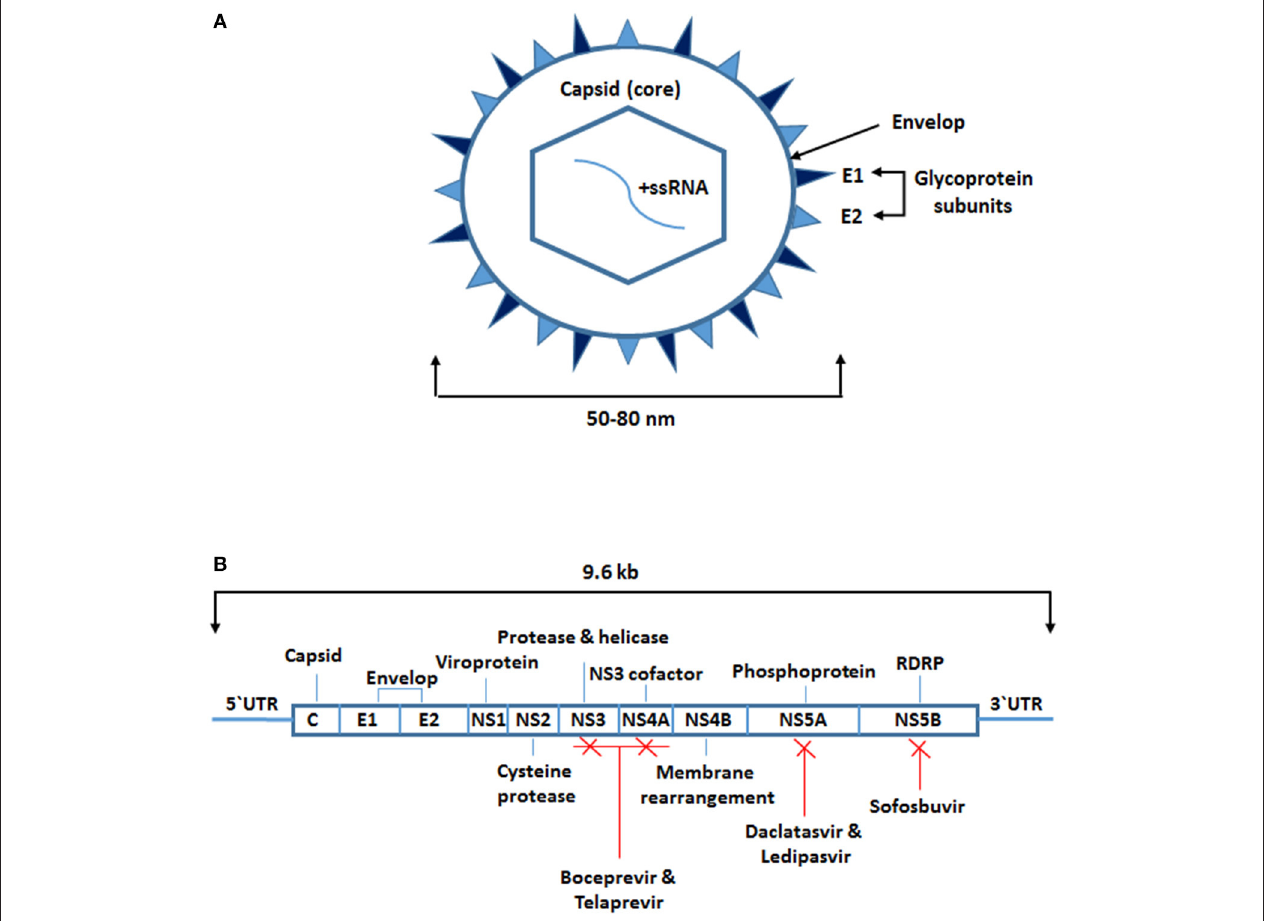
FIGURE 1 | Structure of hepatitis C virus and sites targeted by antiviral therapy. (A) A small spherical enveloped virus with molecular size between 50 and 80nm in diameter. The genome is a positive-sense single-stranded RNA molecule. The structural proteins include the capsid which is the core (C) protein and the envelope subunits glycoproteins (E1 and E2). (B) The viral long open reading frame in-between 5‘ and 3‘ untranslated regions. It encodes for 10 different proteins known as the HCV structural proteins the core (C) and the envelope subunits glycoproteins (E1 and E2) and the non-structural (NS) proteins (NS1, NS2, NS3, NS4A, NS4B, NS5A, and NS5B). Some of the NS proteins are targeted by the protease and RNA dependent RNA polymerase inhibitors (boceprevir, telaprevir, daclatasvir, ledipasvir, sofosbuvir).